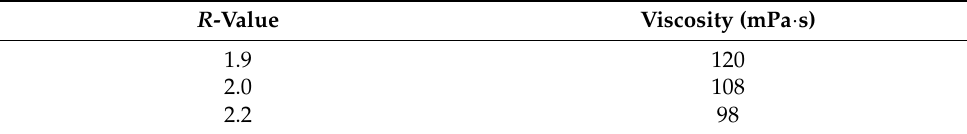
Figure 5. Temperature effect on rheological properties of PU-TiO 2 ink with different R -values. Table 1. R -value influence on the viscosity of PU-TiO 2 ink.